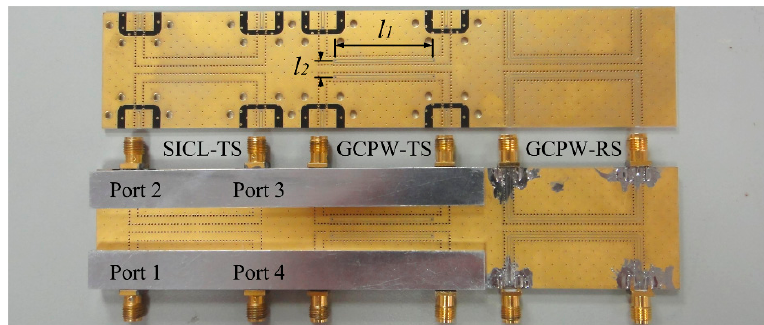
Figure 4. The fabricated test sets with and without the shield and connectors.